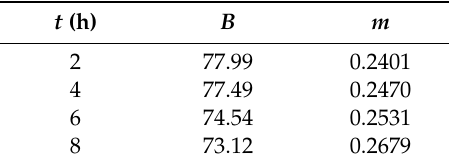
Figure 3. Relationship between U f and γ 20 (DC 3.2 kV). Table 2. Fitting results of flashover voltage.